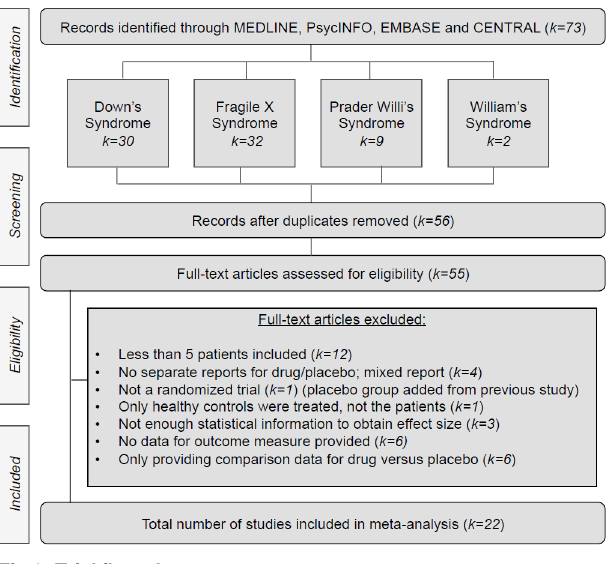
Fig 1. Trial flow